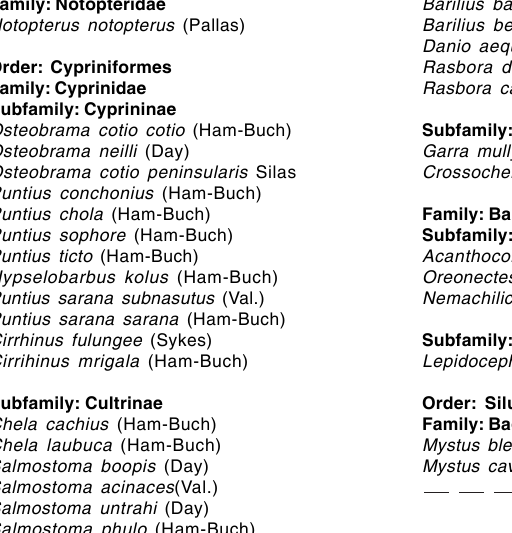
Subfamily: Rasborinae Barilius barna